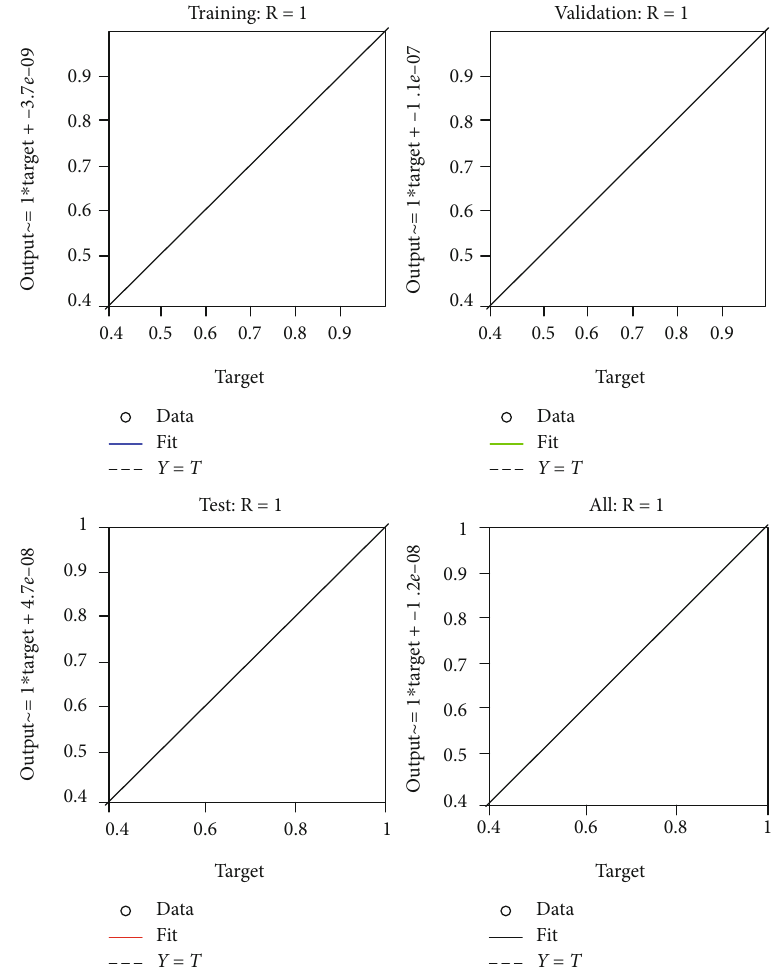
Figure 8: DNN-PV MPPT controller showing best regression.